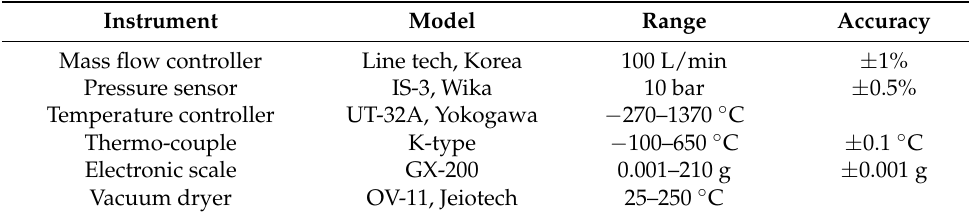
Table 2. Specifications of the components in the system.